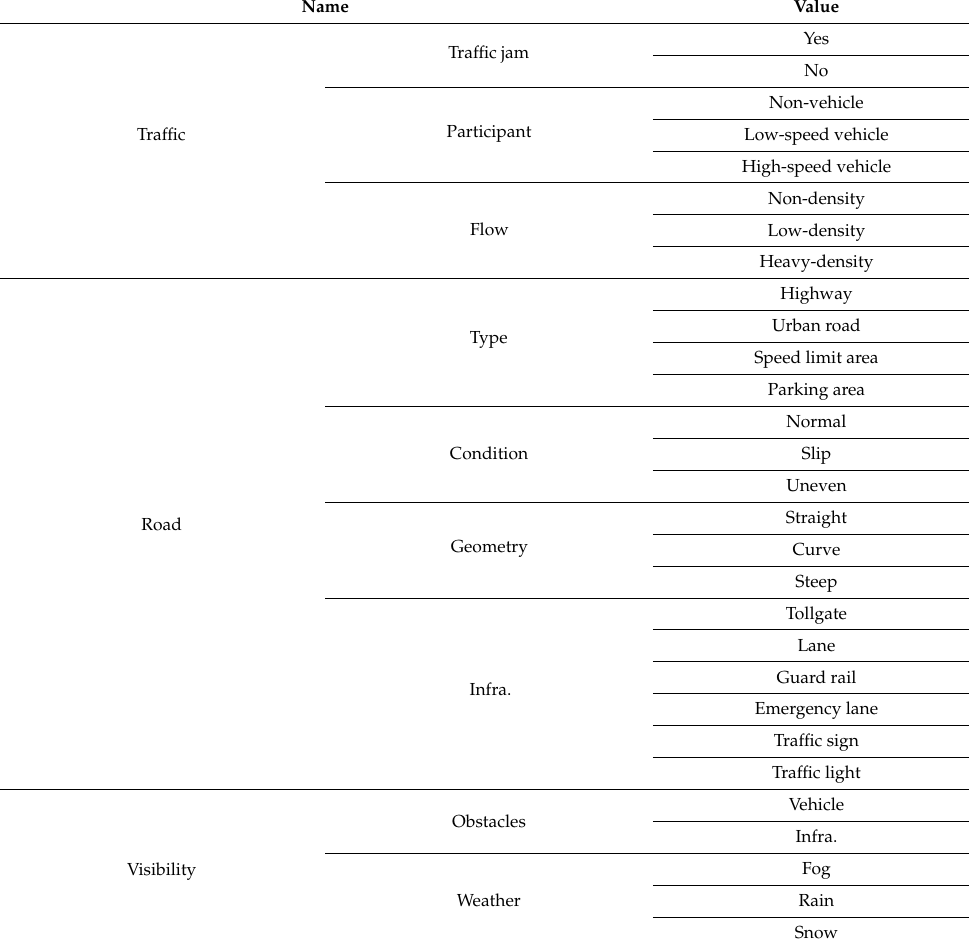
Table 4. Scenario